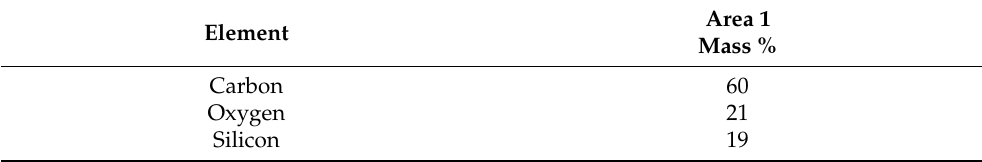
Figure 12. TEM images of a cluster of particles containing SiC. Inset scale: 5 nm − 1 . Table 6. EDXS analysis of the particle cluster that is shown in Figure 12 at the regions that are marked by ‘1’.